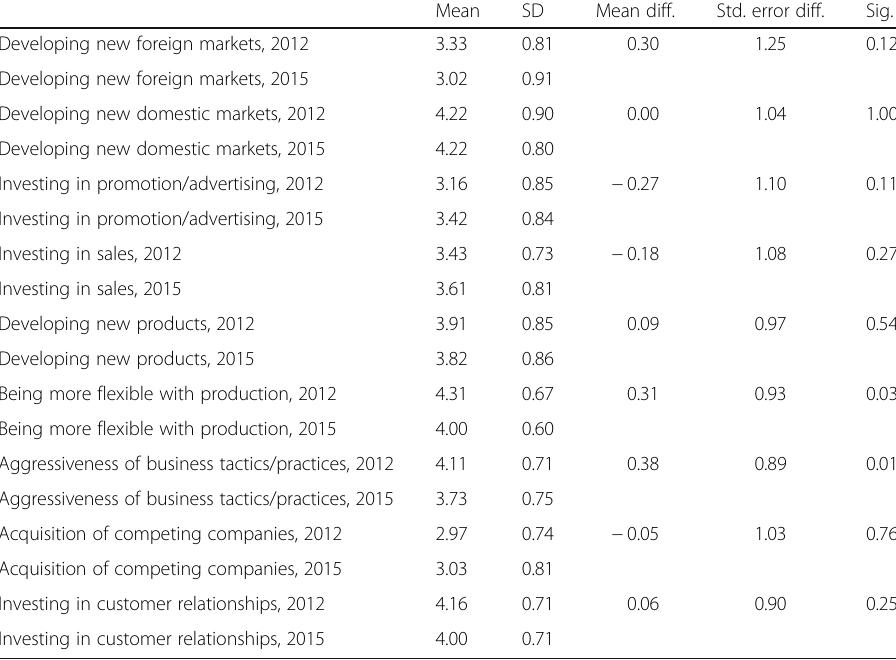
Table 3 Change in innovative efforts between 2012 and 2015 ( n = 46) Mean SD Mean diff. Std. error